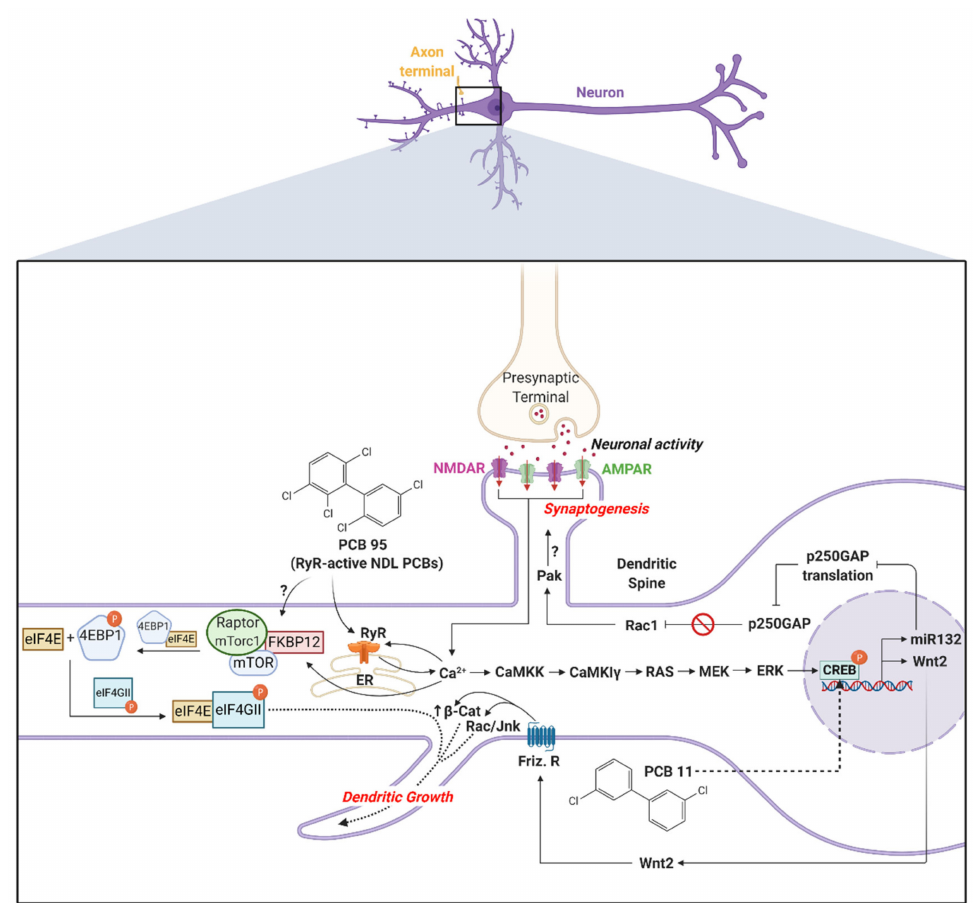
Figure 1. Schematic representing the signaling pathways that mediate the e ff ects of polychlorinated biphenyls (PCBs) on dendritic morphology. Created with